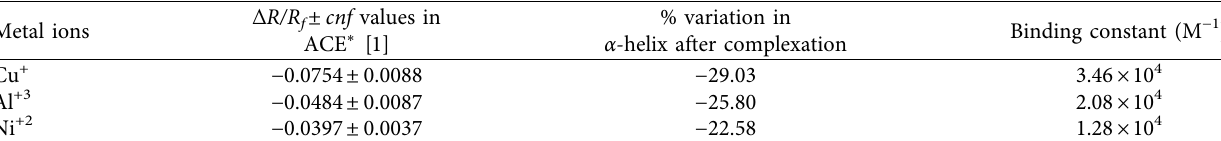
Figure 5: Plot of 1/( A − A ) vs. 1/C � the absorbance of BSA alone and BSA-metal complexes, respectively; C 0 metal ; A 0 and A � concentration of Cu + , Ni +2 , and Al +3 . Bufer: tris (pH 7.4); C � 12 µ M; C � 0, 4, 8, 12, 16, 20, 24, 28, and 32 µ M; (a) BSA metal tal Table 2: Comparison of metal ions-protein interaction results from FT-IR and UV-Vis spectroscopy with those from ACE. Metal